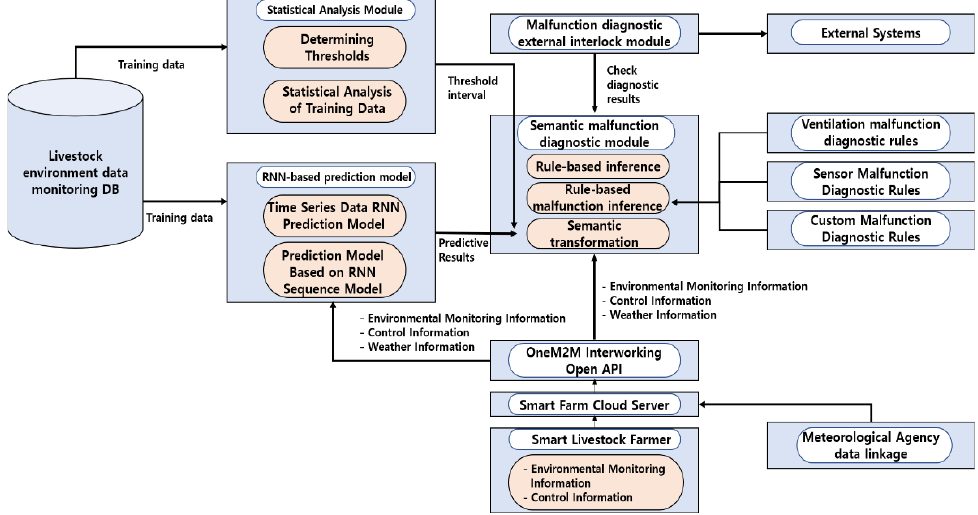
Figure 3. System architecture of a malfunction detection system for ventilation in poultry farms and the functions of various modules.